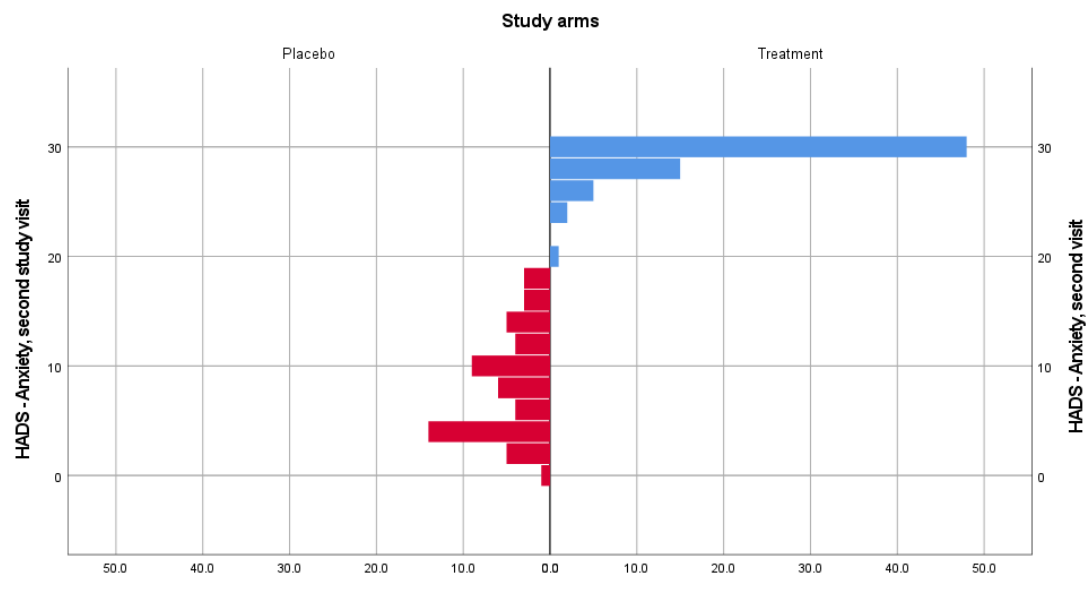
Figure 1. HADS-Anxiety score distribution for the treatment and placebo groups for the second visit.